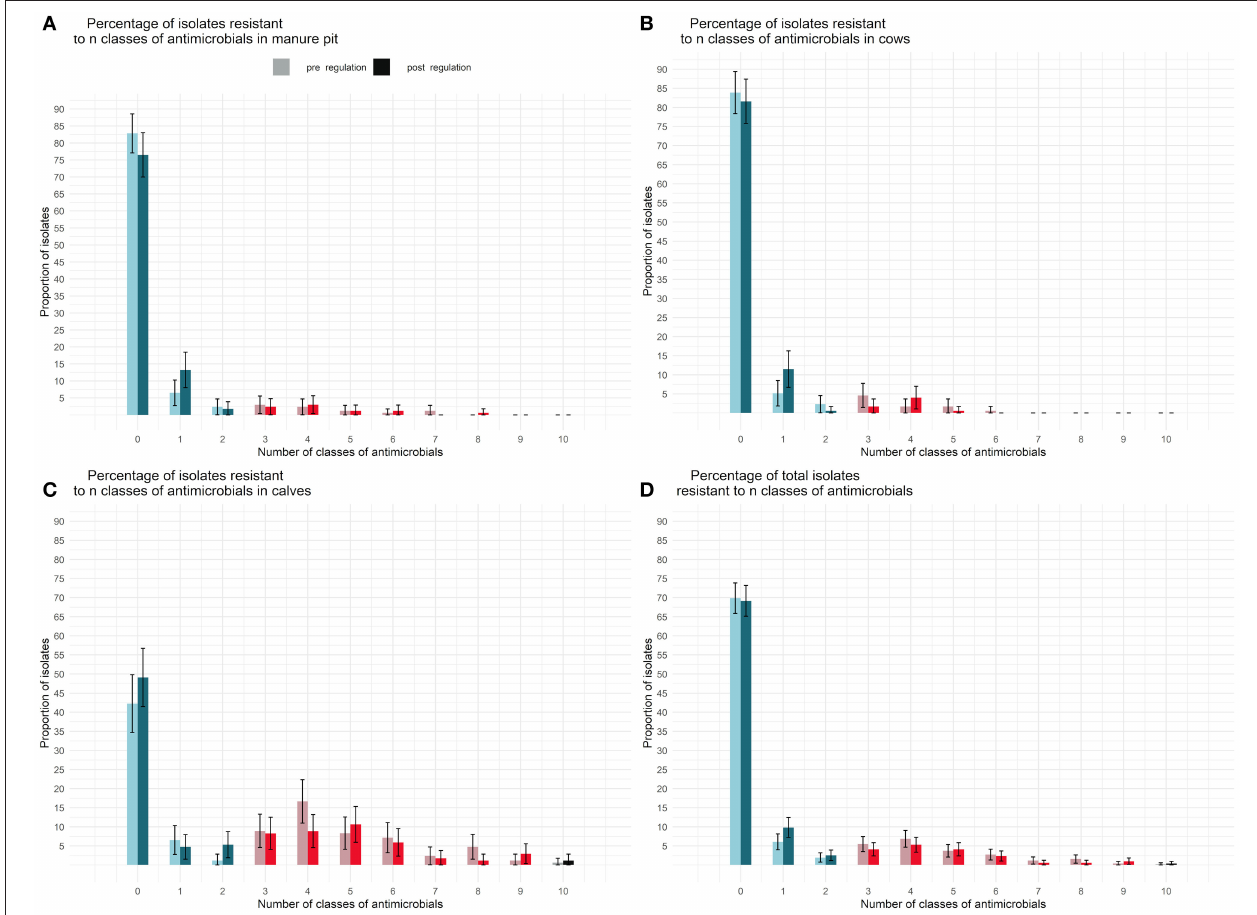
FIGURE 7 | Comparison of the percentage of E. coli isolates resistant to n classes of antimicrobial per sample type [manure pit (A) , cows (B) , calves (C) , herd (D) ] from 87 dairy farms from Québec, Canada, pre (light) and post (dark) regulation implementation. On each farm, between 4 and 6 E. coli were tested for each antimicrobial. In dark and light blue, isolates are non MDR. In dark and light red isolates are MDR. In gray and black isolates are extensively